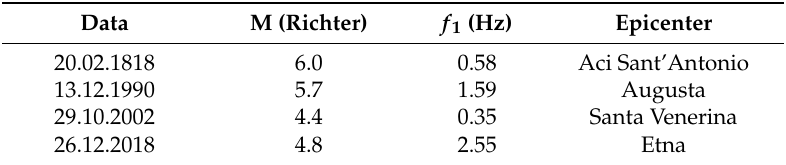
Table 2. Main properties of the utilized